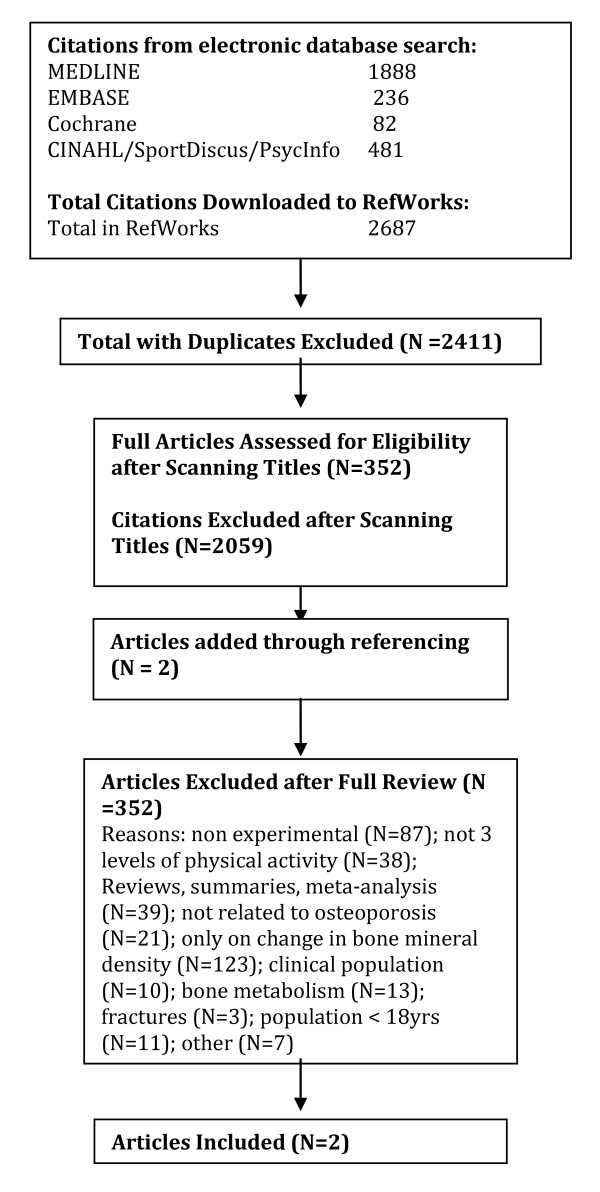
Results of the Literature Search for Osteoporosis.